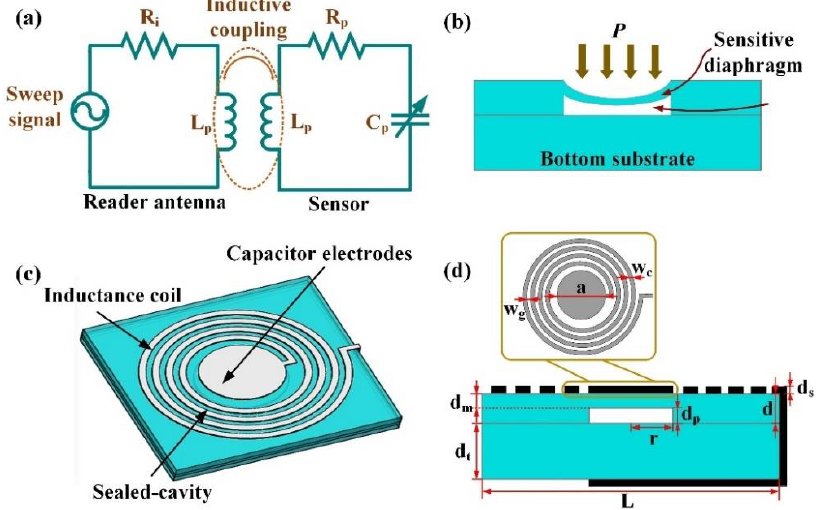
Figure 1. Schematic diagram of sensor operation. ( a ) Illustrative equivalent circuit schematic model of LC measurement. ( b ) Pressure sensing principle. ( c ) Structure of the sensor. ( d ) 3D model of the sensor. Table 1. Geometrical parameters of the designed LC wireless passive sensor.